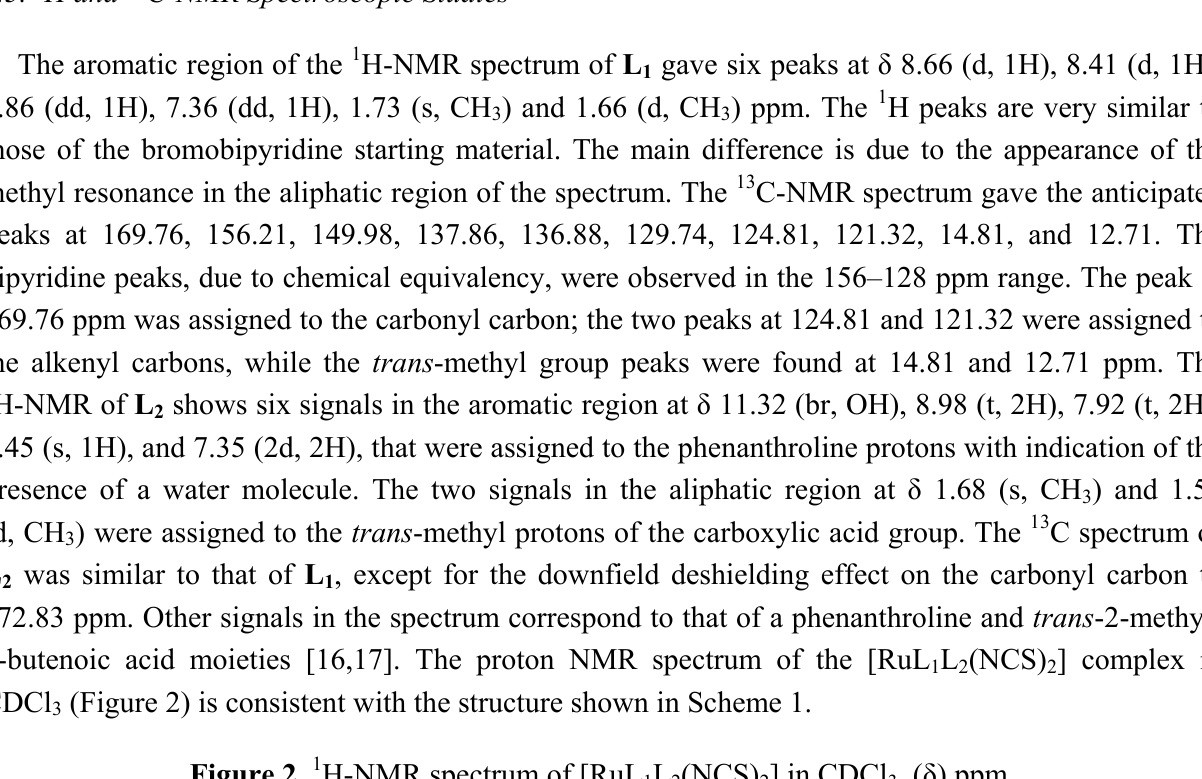
Figure 2. 1 H-NMR spectrum of [RuL